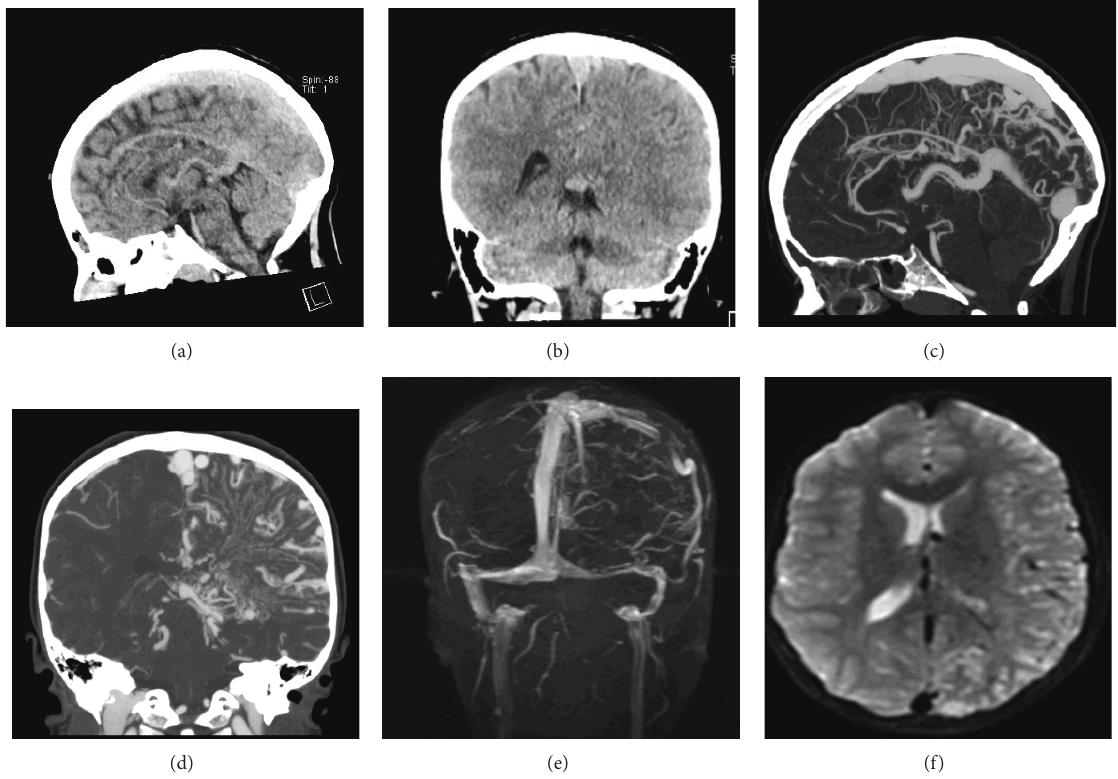
Figure 1: Noncontrast computed tomography in (a) sagittal and (b) coronal view revealed prominent left cortical veins concerning an AVM. CT angiography in (c) sagittal and (d) coronal view confirmed the diagnosis of left hemispheric cerebral proliferative angiopathy. Magnetic resonance venogram (e) showed the lesion and confirmed the absence of dural AV fistula. (f) Diffusion-weighted MRI showed no areas of